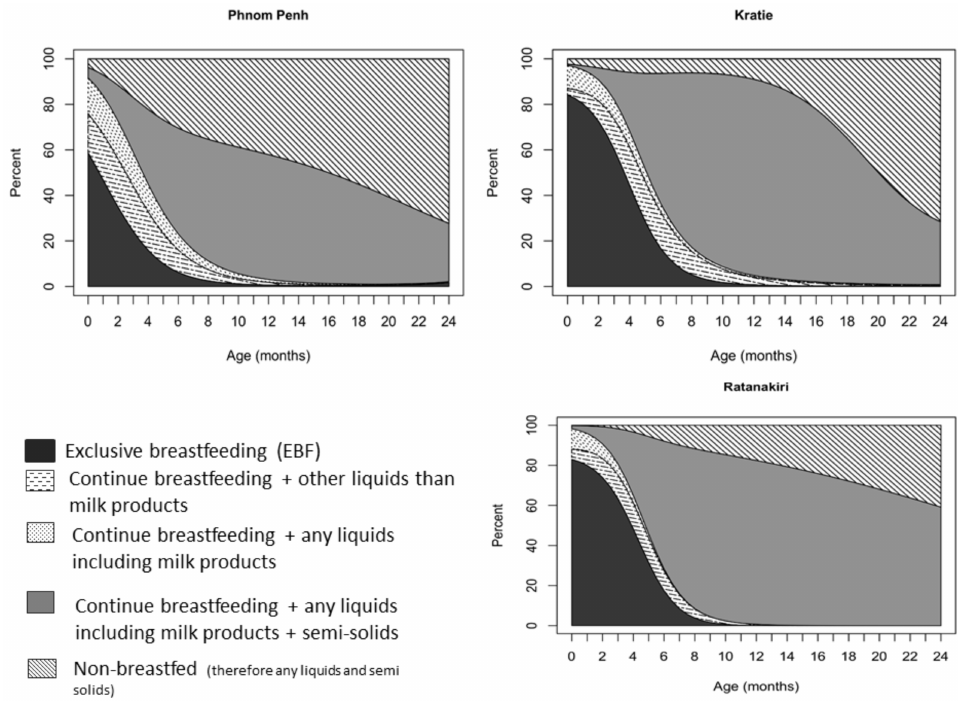
Figure 3. Infant feeding practices by age (note: BF: continued breastfeeding).